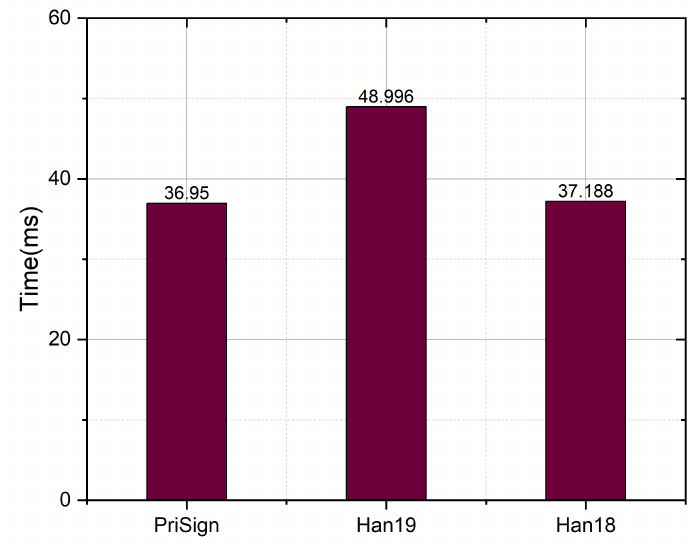
Figure 16. Time comparison with Han19 [9] and Han18 [8] in ObtTkt.I .